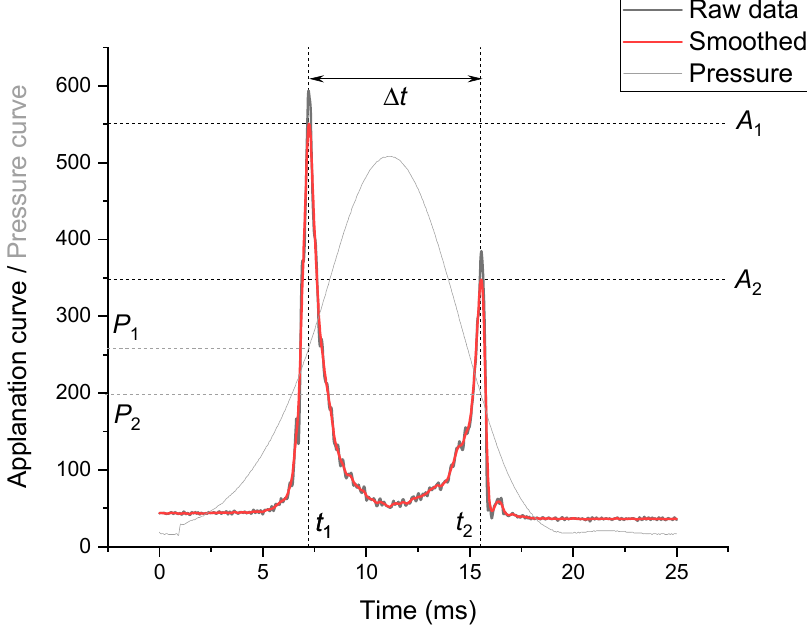
Figure 1. The applanation curve recorded by ORA (control group, before WDT, patient 11). The ORA additionally determines 37 parameters describing the shape of the applana- tion curve representing the change of the curvature of the cornea during the measurement. They represent properties of corneal behaviour separately in two applanation areas, includ- ing the area under the curve (p1area, p2area), upward slope (uslope1, uslope2), downward slope (dslope1, dslope2), peak width (w1, w2), peak height (h1, h2)), length of the curve around the peaks (path1, path2), smoothness of the peaks (aindex, bindex), noise (aplhf), and six additional parameters (dive1, dive2, mslew1, mselw2, slew1, and slew2). A detailed description of the parameters is presented in the Supplementary Files–Table